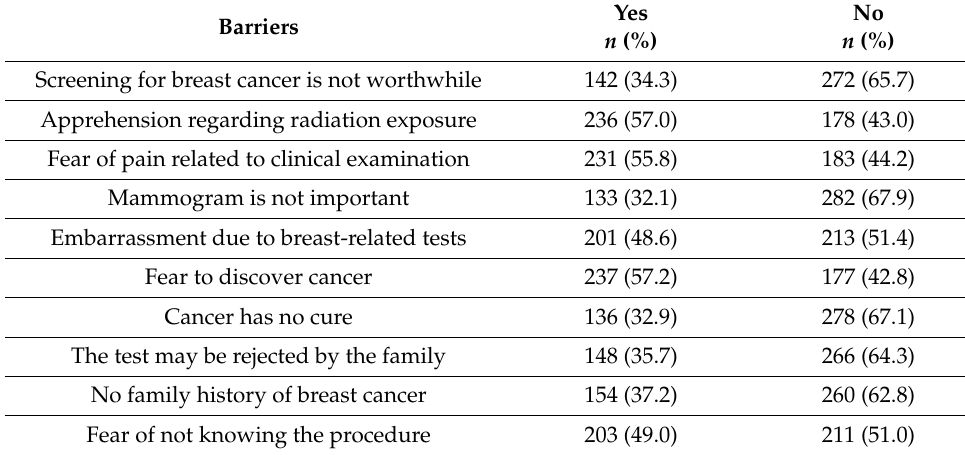
Table 3. Barriers towards uptake of mammogram screening among the participants ( n =